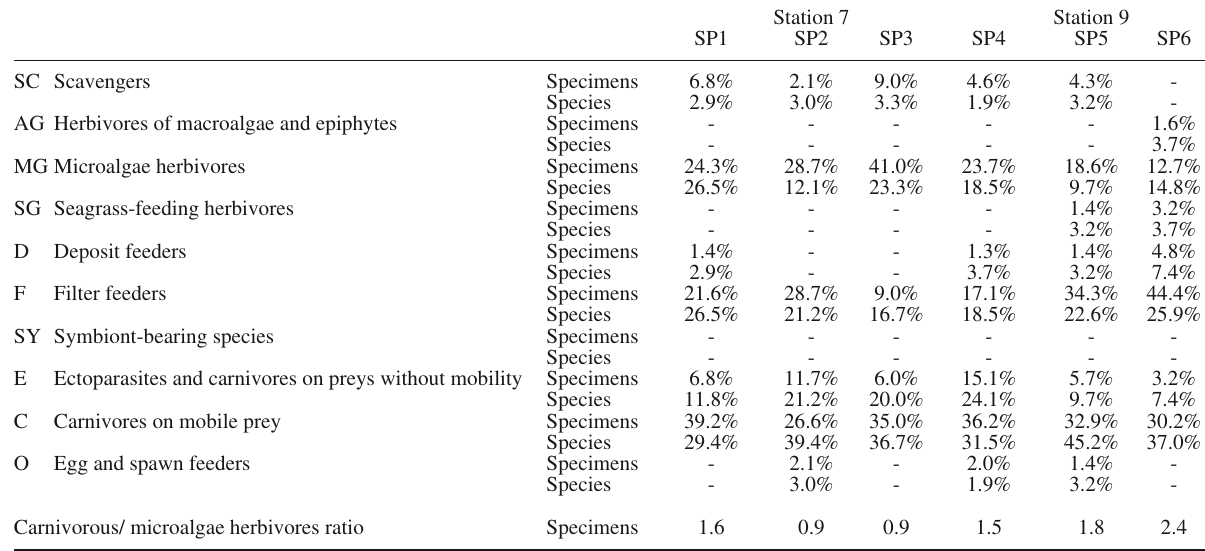
Table 5. – Number of specimens and species and their percentage for each feeding guild for the